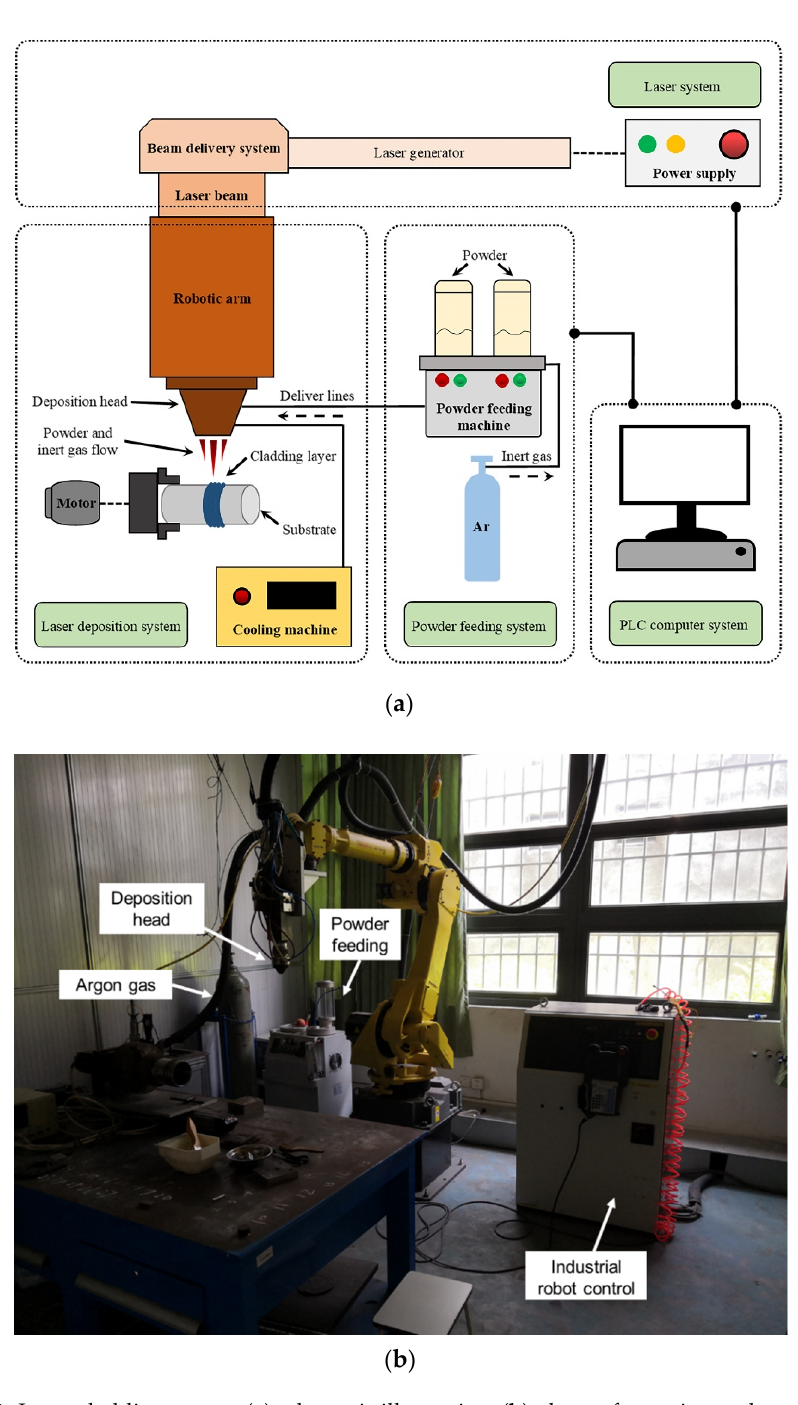
Figure 1. Laser cladding system ( a ) schematic illustration; ( b ) photo of experimental equipment.